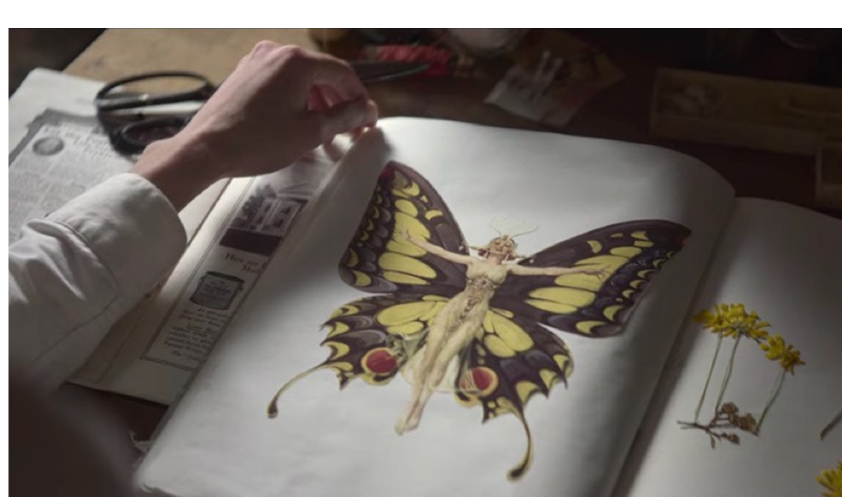
Figure 2. The Power of the Dog . Netflix.